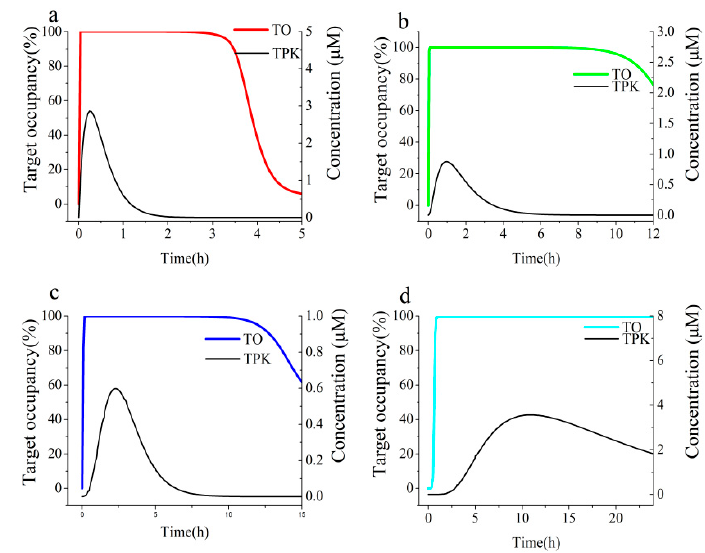
Figure 7. Simulations of the time course of AGH engagement by acarbose in the UWLs of the four di ff erent intestinal segments in rat with BK-TPK model ( a ) duodenum, ( b ) jejunum, ( c ) ileum, ( d ) colon. Black solid lines represent TPK concentration-time profiles; red, green, blue and cyan solid lines represent target occupancy (TO) time course profiles.